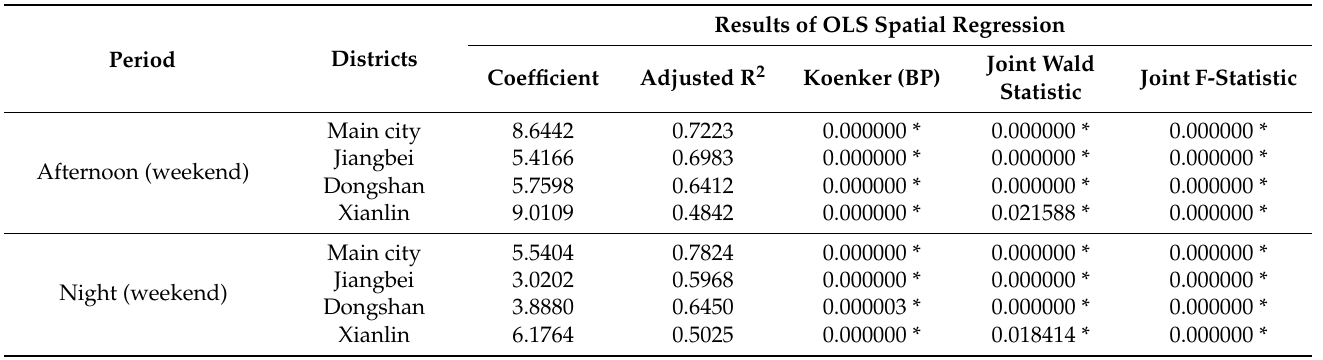
Results of OLS Spatial